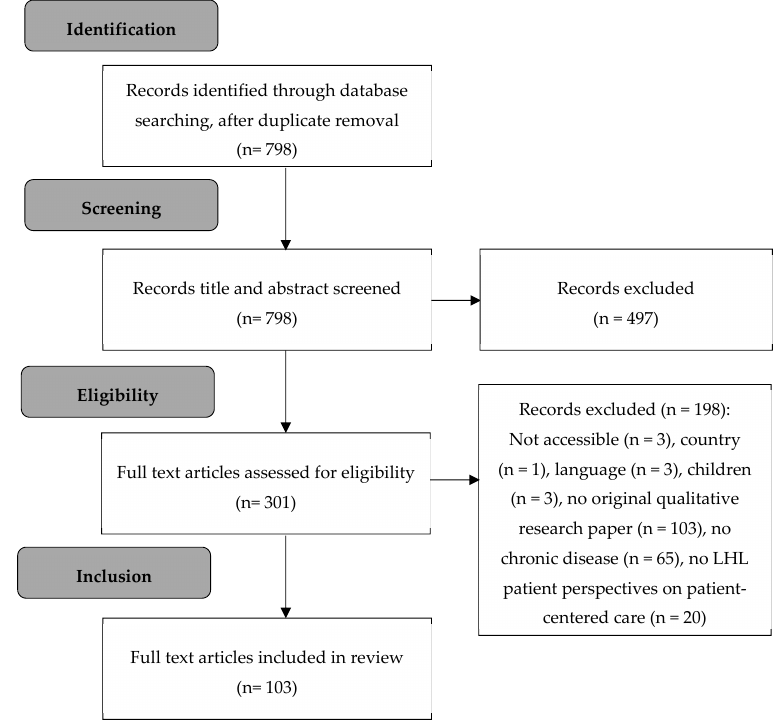
Figure 2. Flow chart of study selection.